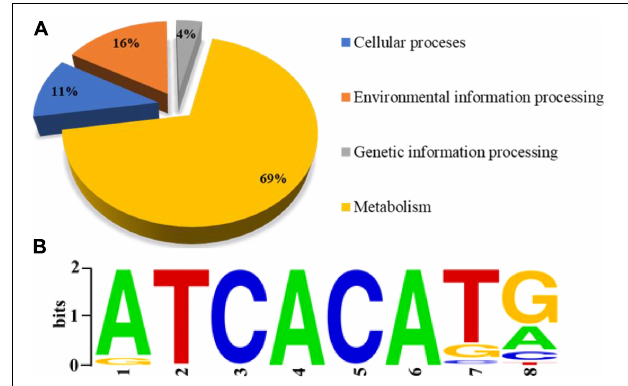
FIGURE 1 | Genome-wide analysis of the Vfr regulon by chromatin immuno-precipitation sequencing (ChIP-seq). (A) Pie chart showing the shoeing of Vfr targets with functional categories defined in the Pseudomonas database (http://pseudomonas.com). (B) The most significant motif identified by ChIP-seq using the HOMER tool is shown. The height of each letter is proportional to the level of conservation at that site.